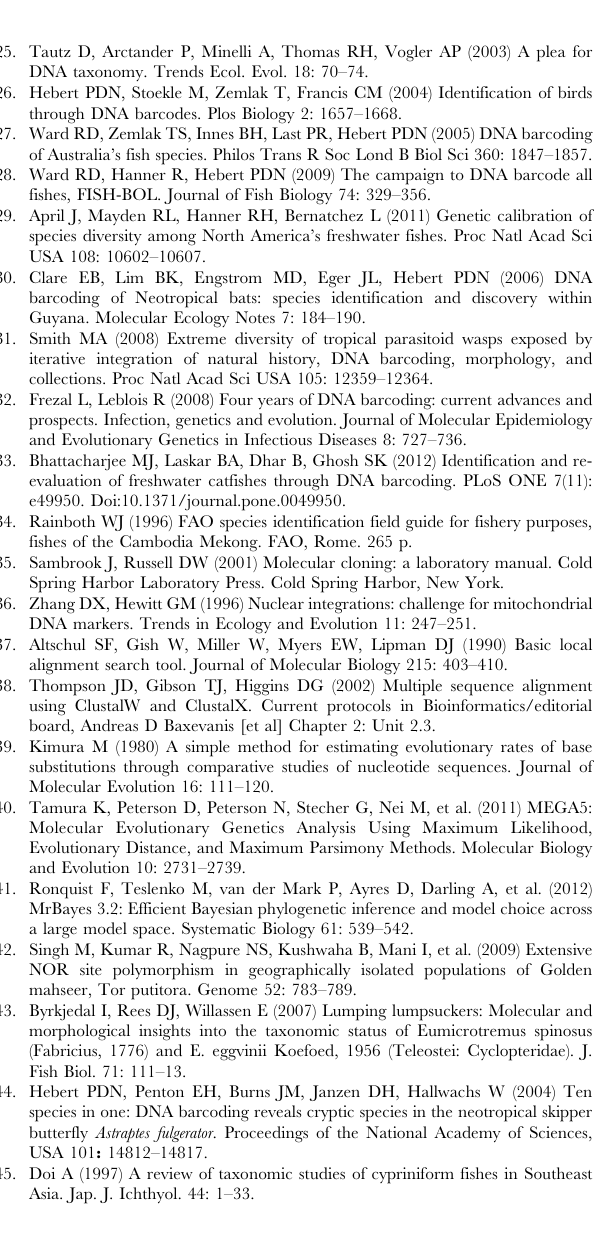
alone correspond to the sequences of samples morphologically identified as Tor progeneius, but are found conspecific with Tor putitora in this study hence, marked as Tor putitora. The green coloured sequences correspond to the cases of abnormal clustering. Table S1 List of the studied species, GenBank Accession of the analyzed sequences and the geographical posi- tions of the sample. Table S2 Morphometric details of the studied species. Table S3 Pairwise K2P divergence matrix between the